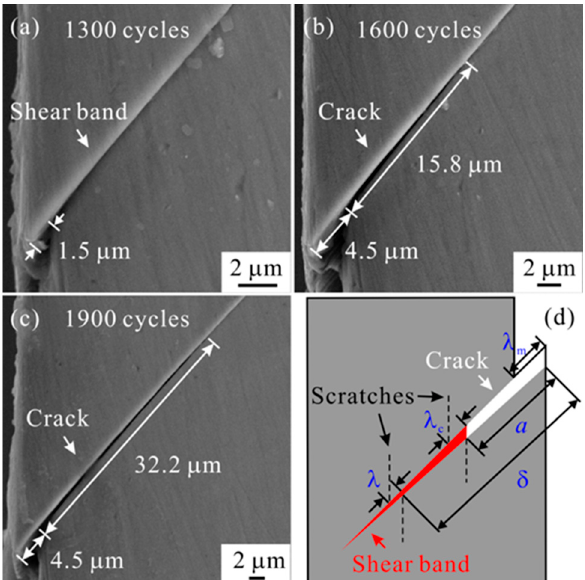
Figure 8. SEM observations on the damage evolution under different cycles of ( a ) 1300, ( b ) 1600 and ( c ) 1900. ( d ) Illustration of the shear band and shear-band crack and the definitions of some parameters, i.e., the local shear offset ( λ ), the distance ( δ ) from the origin site of shear band, the maximum shear offset ( λ m ), the critical shear offset for cracking ( λ c ), and the crack length (a) [48].